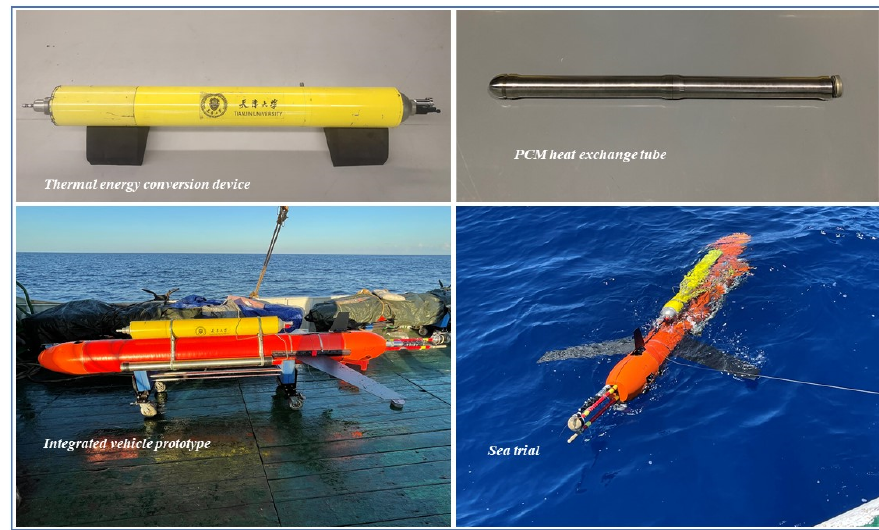
Figure 10. The prototype of Smart Float was tested in the sea trial.